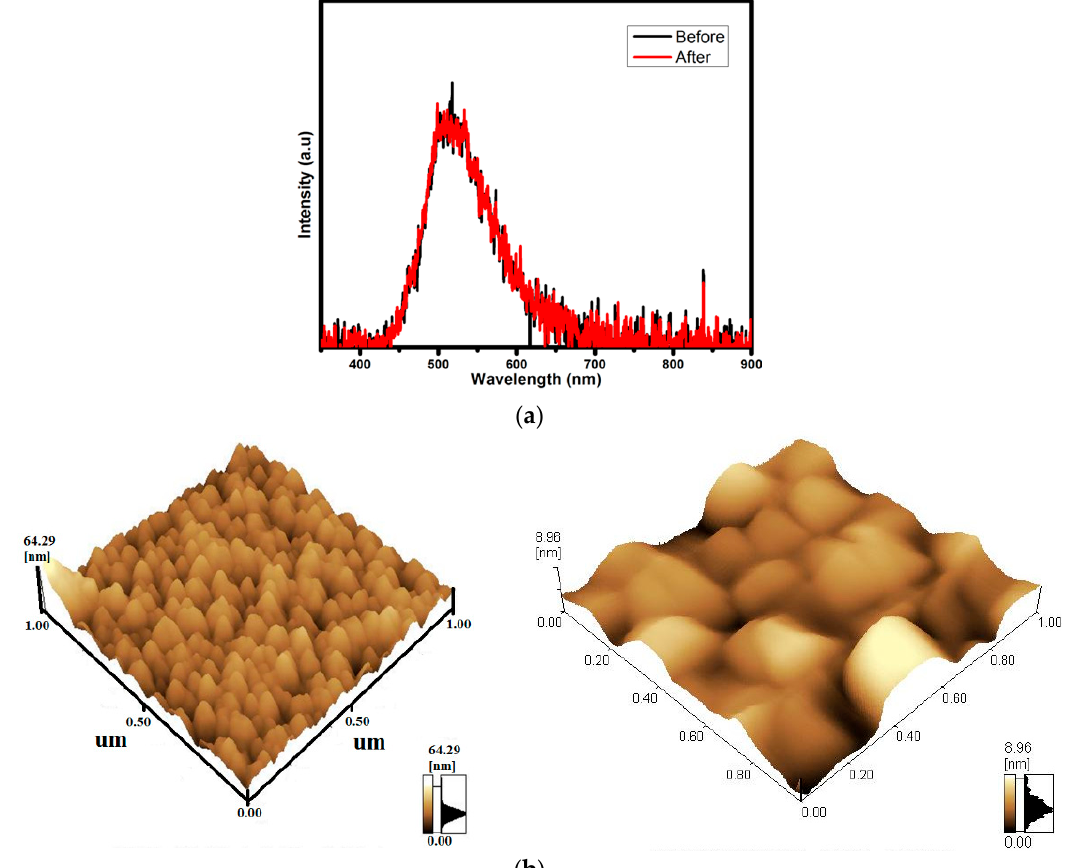
Figure 10. ( a ) The CL spectra before and after degradation of the ZnO film exposed to H 2 flow for 60 min; and ( b ) AFM micrographs of the sol-gel ZnO film, measured before degradation and after degradation in the degraded area [49].